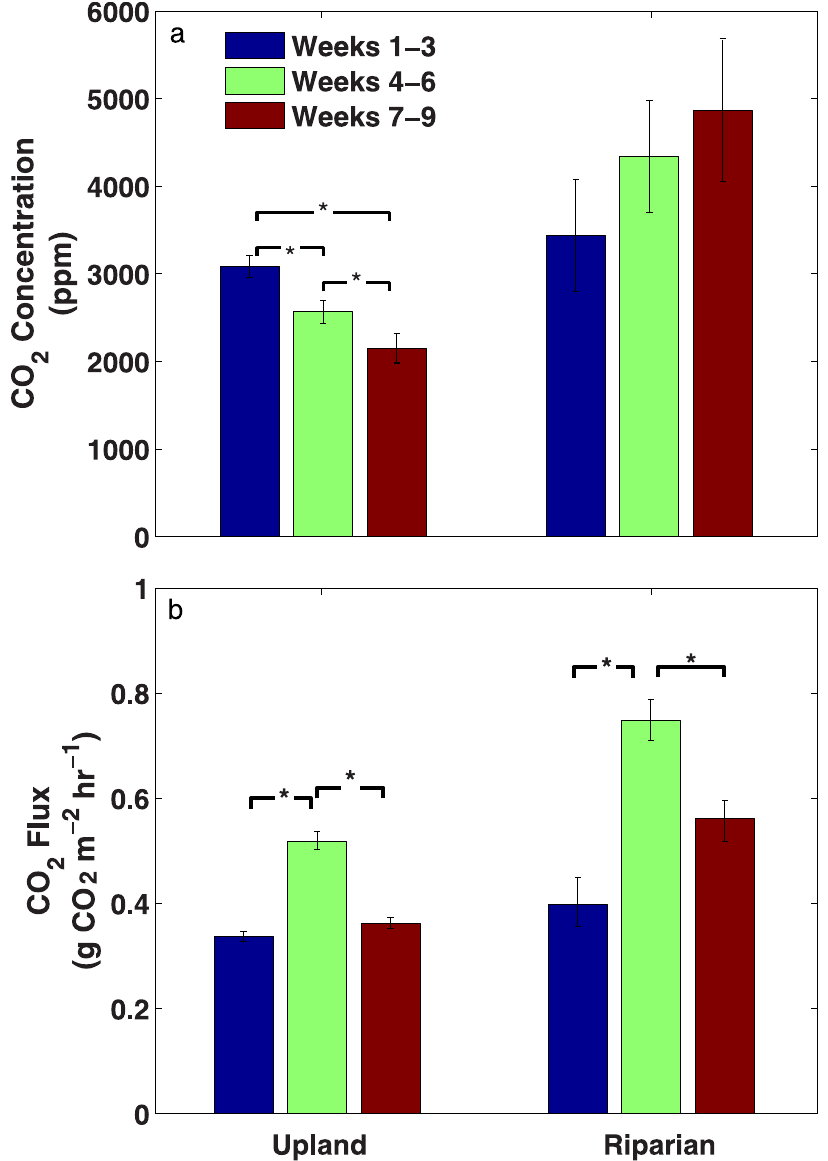
Fig 2. Soil CO 2 concentrations and flux. Comparison of mean CO 2 concentrations across three depths and flux between and within upland (n = 23) and riparian (n = 9) plots during wet (Weeks 1–3), transition (Weeks 4–6), and dry (Weeks 7–9) periods of the 2013 growing season. Asterisks ( (cid:3) ) indicate significant differences between groups (p < 0.05, Welch’s ANOVA). Bars indicate standard errors of the mean.